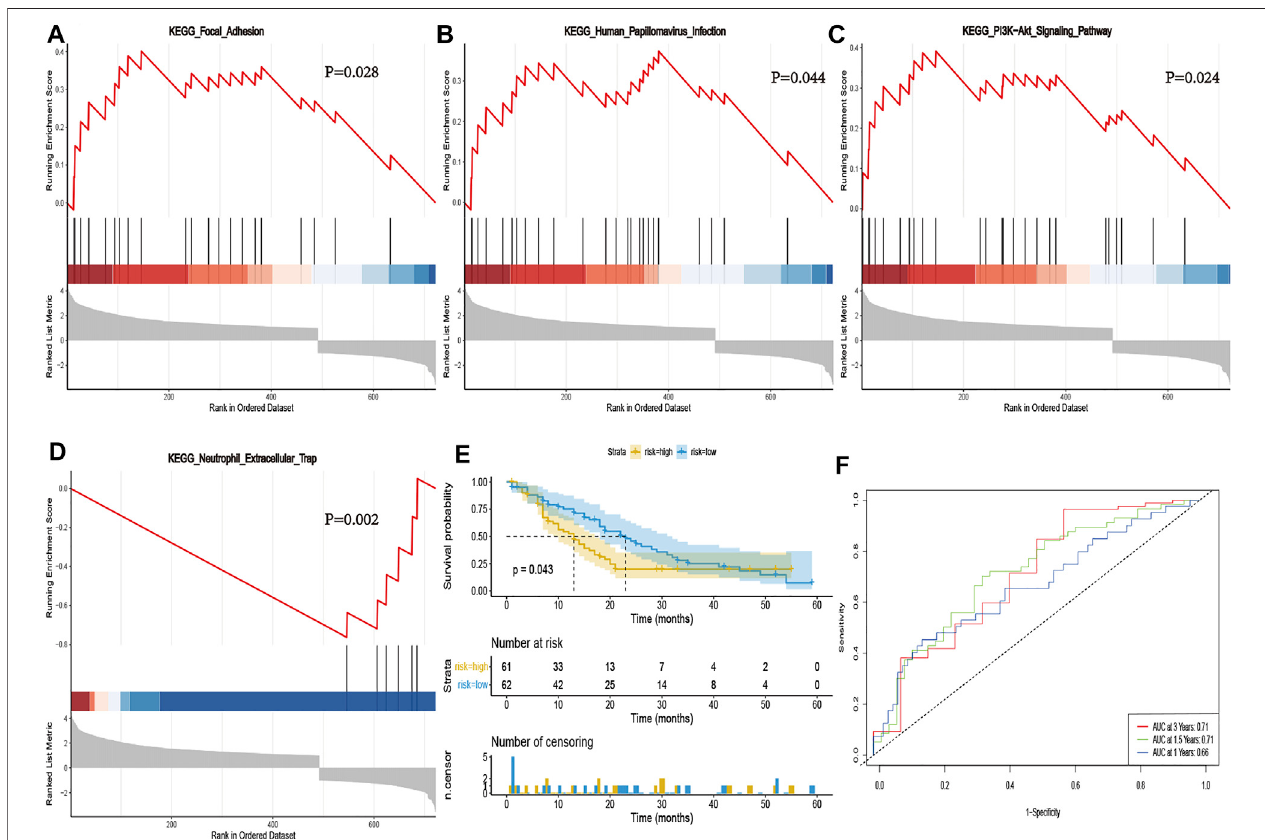
FIGURE 6 | Validation of the necroptosis-related signature in GSE71729. GSEA validated activity of focal adhesion (A), human papillomavirus infection (B), PI3K- Akt signaling pathway (C) , and neutrophil extracellular trap (D) . (E) Kaplan-Meier curve of OS in the high- and low-risk groups strati fi ed by the necroptosis-related signature in GSE71729. (F) The ROCanalysis in GSE71729. The AUC values for 1-, 1.5- and 3- years were 0.66, 0.71 and 0.71 in the GSE71729 cohorts,